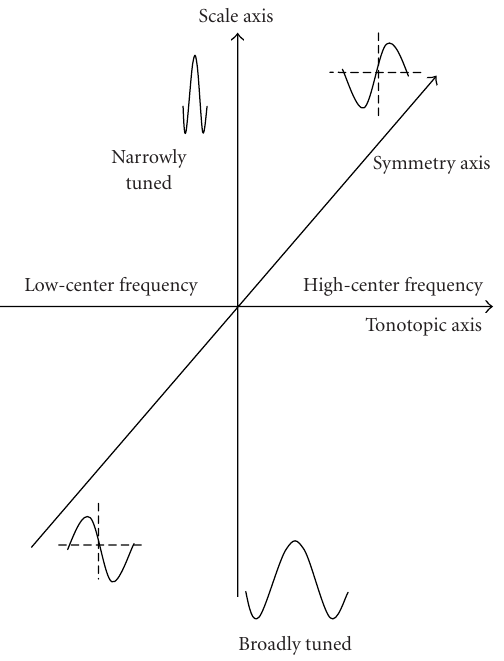
Figure 4: Schematic of the cortical model. It is proposed in [9] that the response fields of neurons in the primary auditory cortex are ar- ranged along three mutually perpendicular axes: the tonotopic axis, the bandwidth or scale axis, and the symmetry or phase